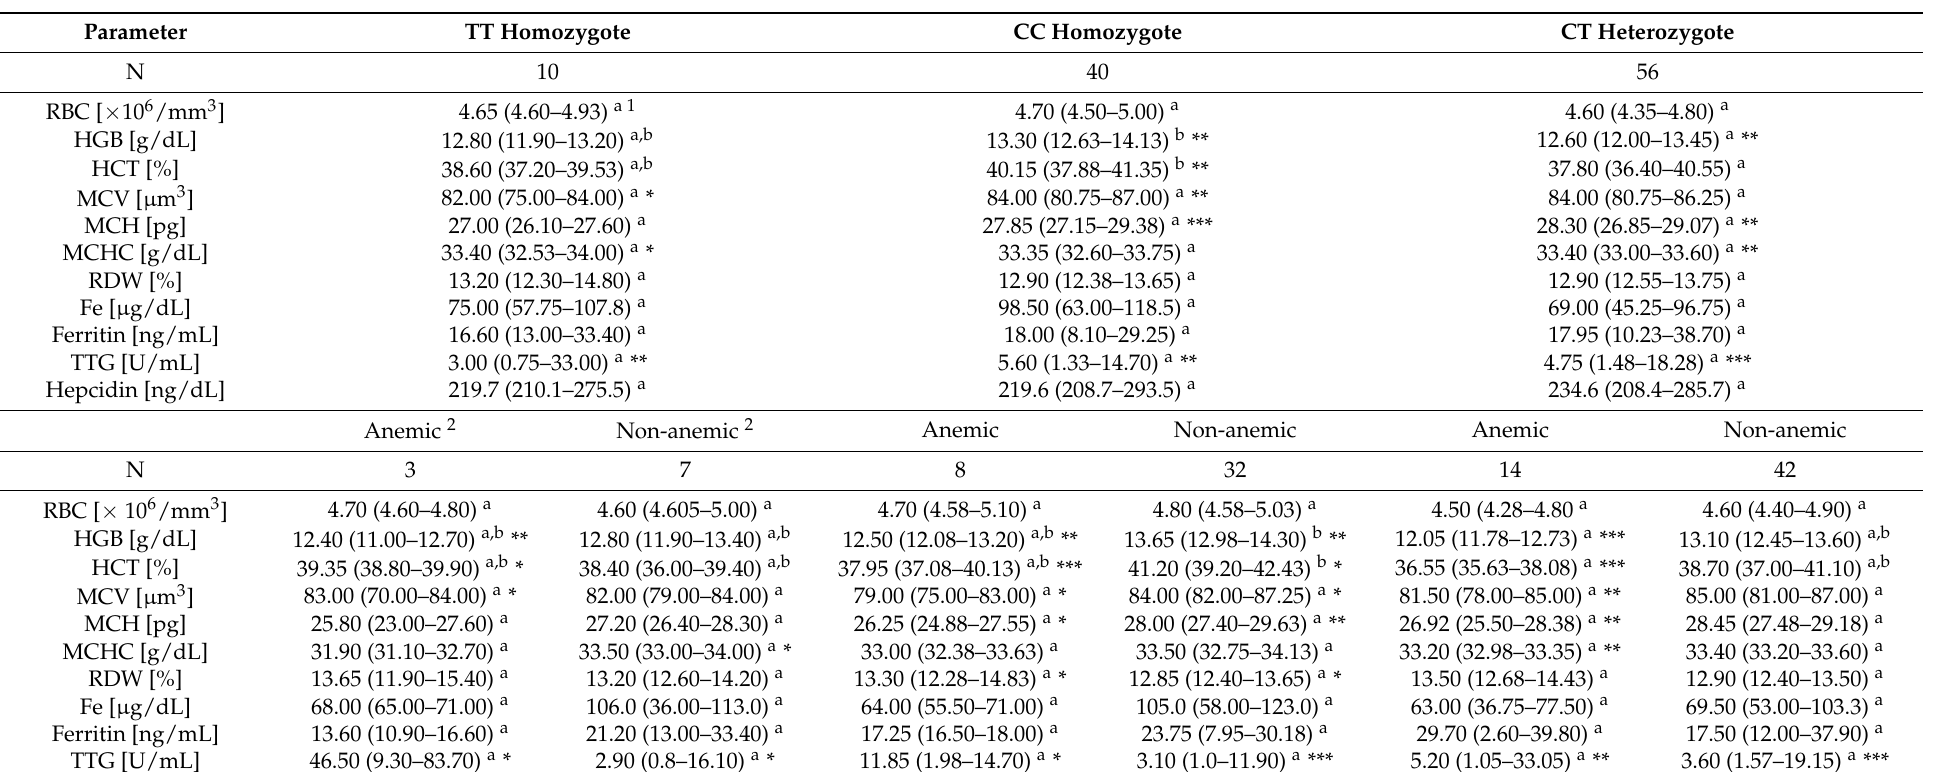
Table 3. Hematological characteristics in children with CD after 12 months of GFD, according to the genotype. Data are expressed as a median (P25–P75).